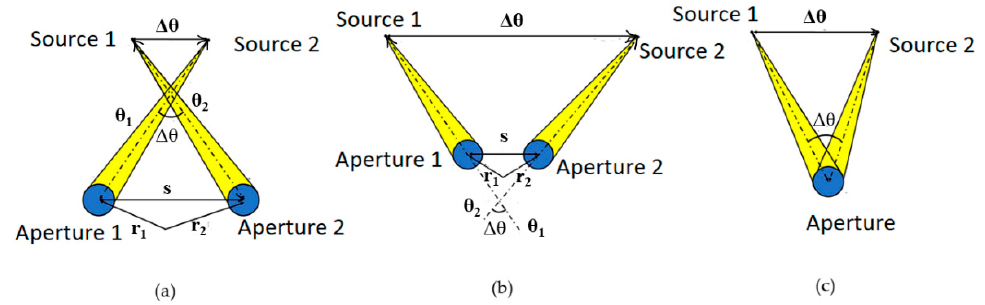
Figure 1. Imaging path geometries. ( a ) Sensing paths cross; ( b ) Sensing paths do not cross; ( c ) Sensing at a single aperture.